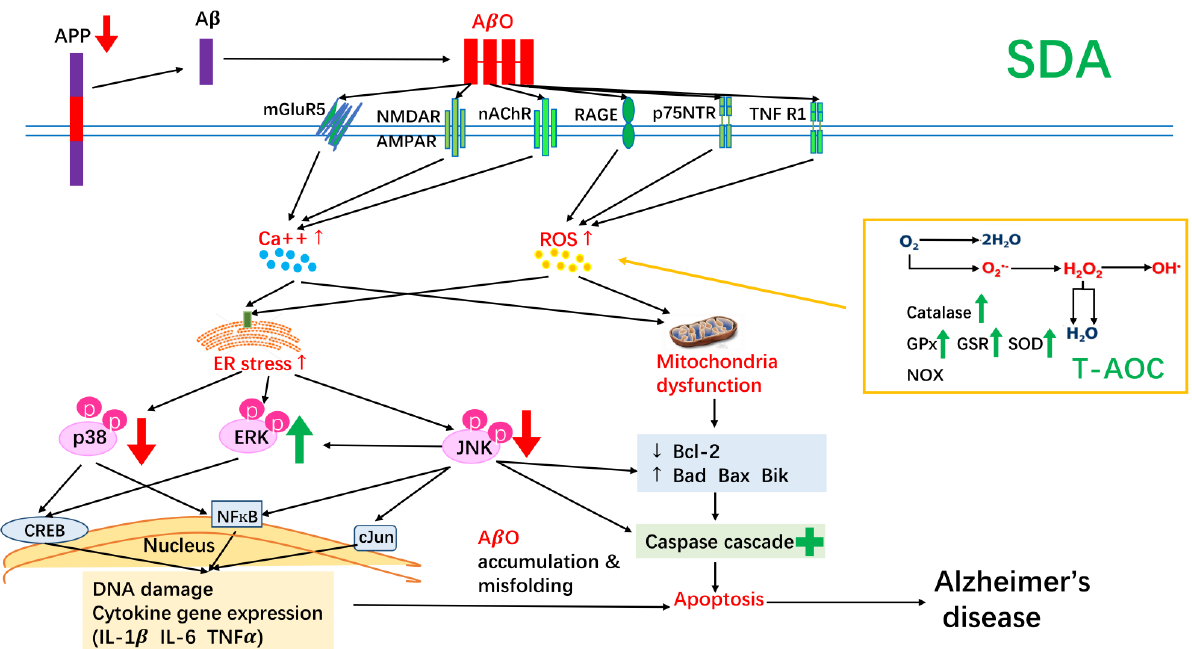
Figure 7. A summary of the neuroprotective effect of SDA on amyloid β -induced neurotoxicity in rat hippocampal cells. SDA was able to regulate expression of apoptotic mediators, improve total anti-oxidant capacity, reduce expression of pro-inflammatory mediators, inhibit expression of the precursor of Aβ, attenuate stress -triggered apoptotic JNK/p38 phosphorylation, and activate survival-related ERK signaling pathway.